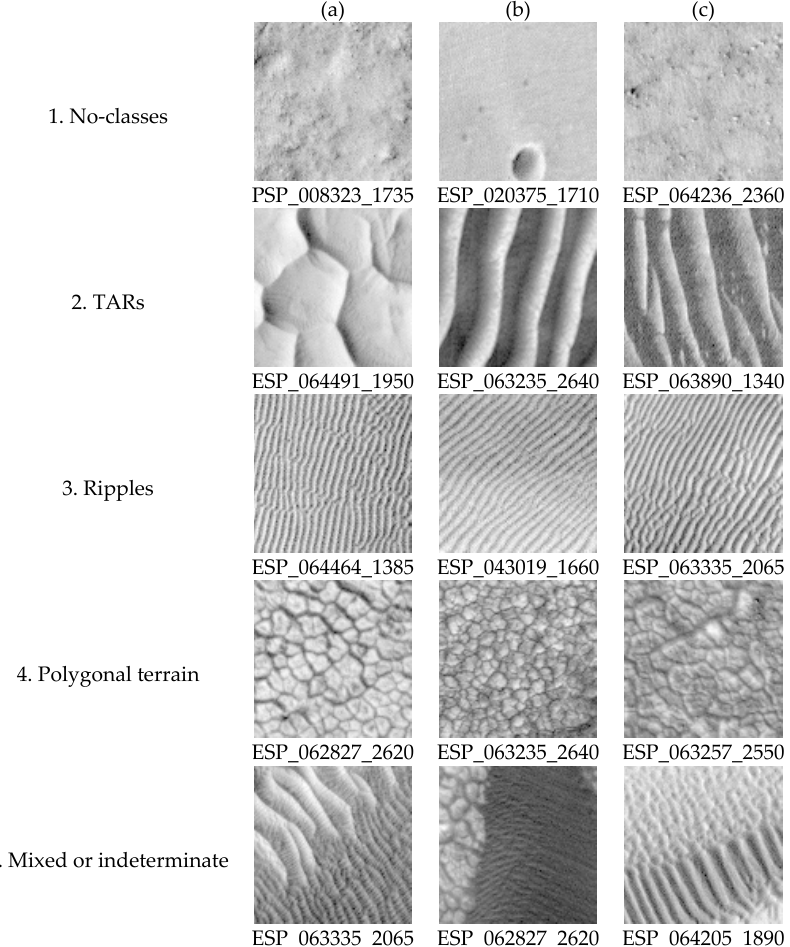
Figure 1. A set of example tiles. All tiles are 100 × 100 pixels (50 × 50 m), north is up, and all images are illumined from the west. Note the difference in wavelength between TARs (2) and ripples (3). Note also the similarity between the more networked TARs in (2a) and the polygonal terrain (4). Mixed tiles (5) were excluded from labeling and training. (5a) contains TARs and dark ripples, (5b) contains dark ripples and polygonal terrain, and (5c) contains darker TARs and light ripples.